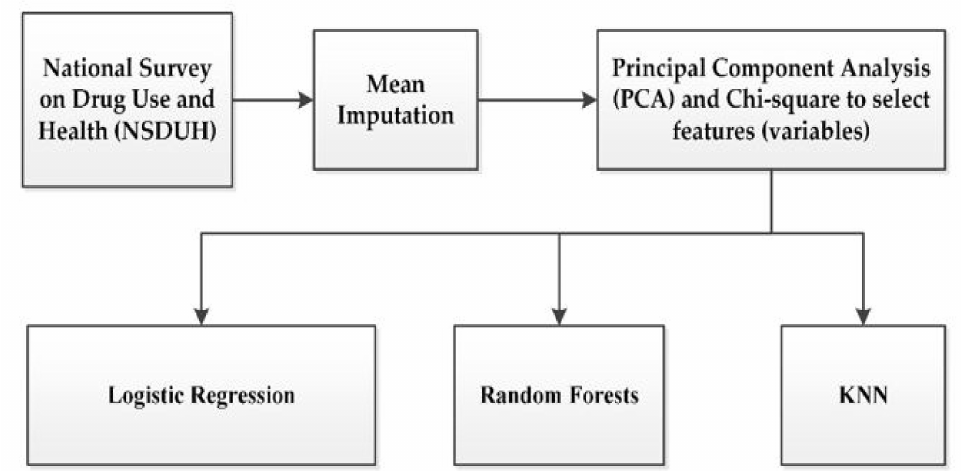
Figure 1. Overall process of building predictive